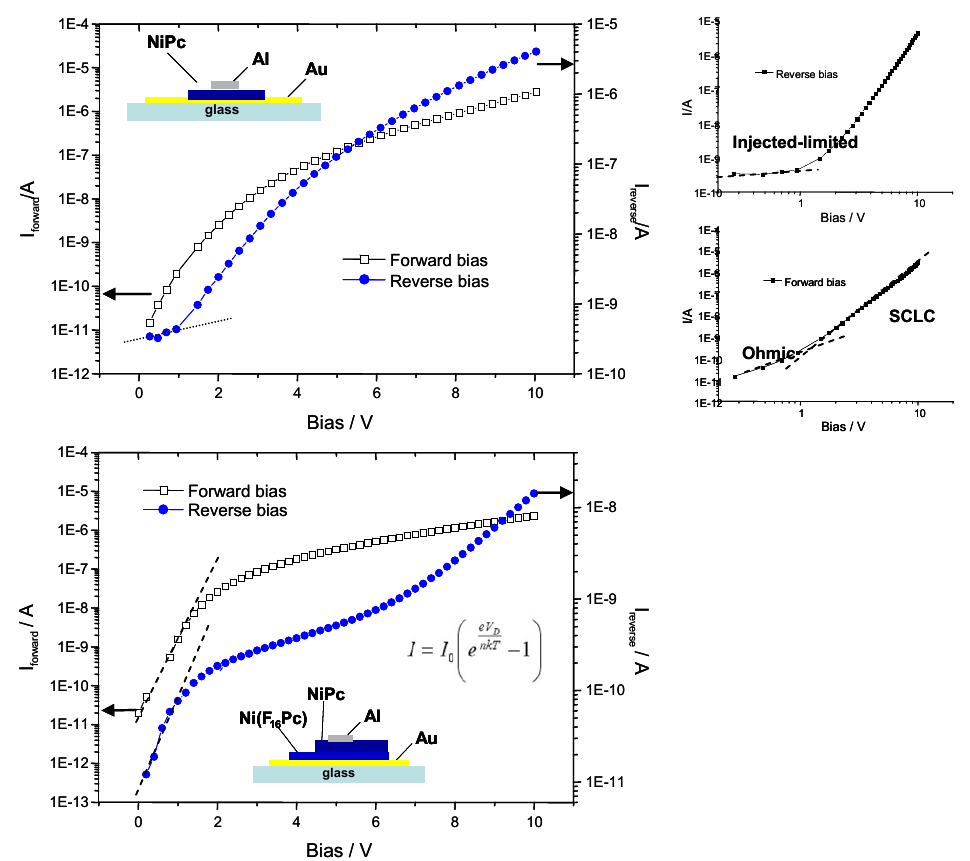
Pc)|Al bilayer device in semi-logarithmic scale Figure 3. Current-voltage behavior of Au|NiPc|Ni(F 16 (bottom) compared to that of Au|NiPc|Al sample (top), the log-log curves are shown . Straight lines correspond to Schottky, Ohmic and SCLC equation fittings, depending on the